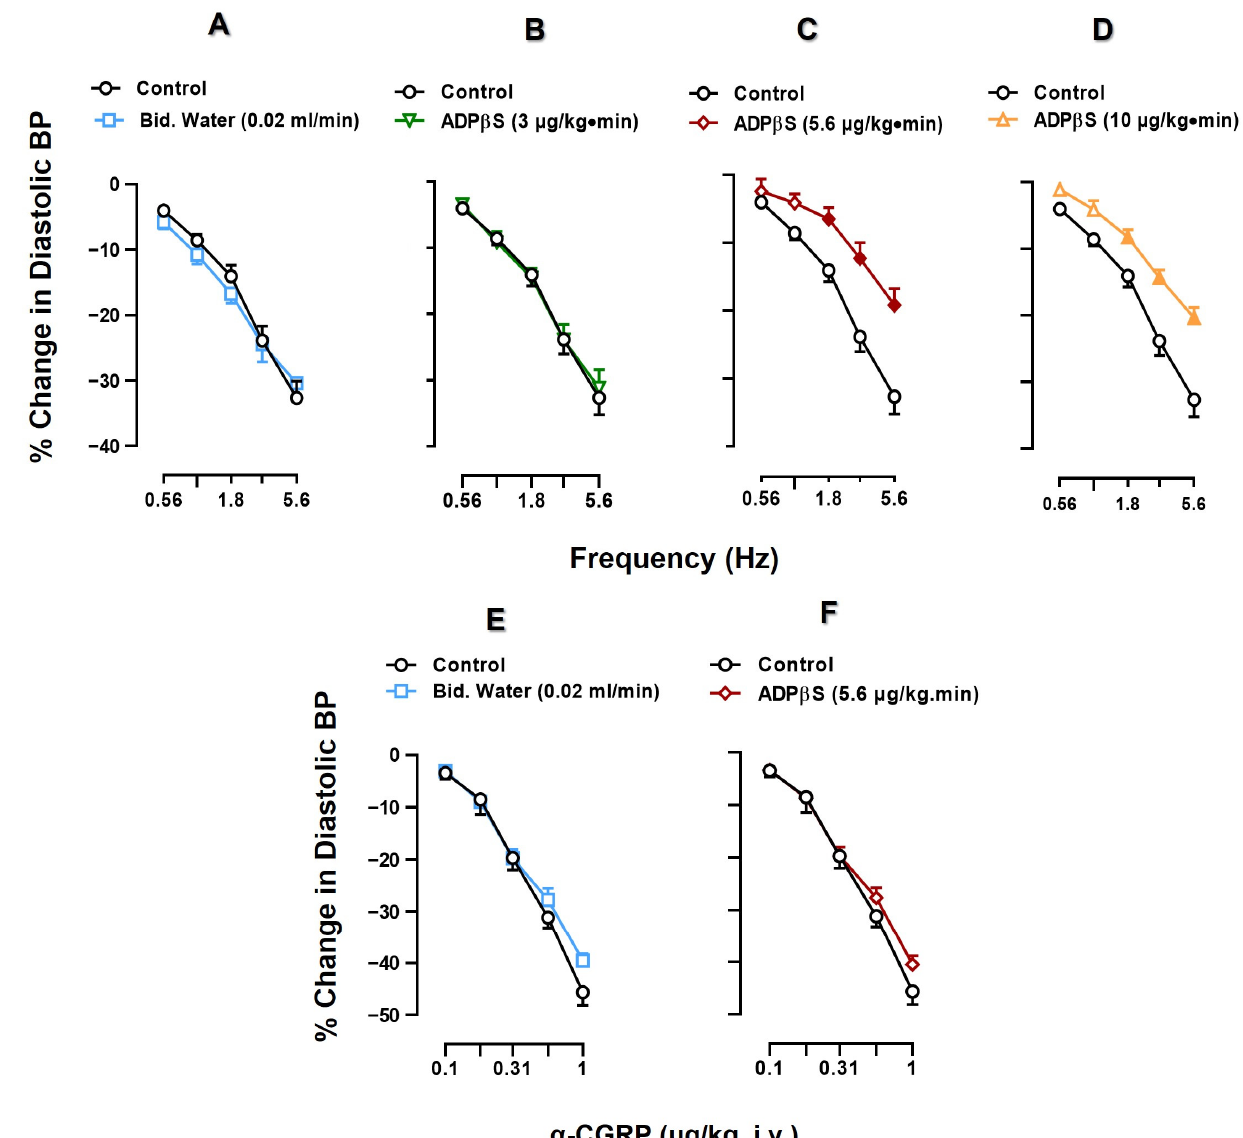
Figure 1. Comparative analysis of the effects produced by infusions of bidistilled water (Bid. Water) or ADP β S on the vasodepressor responses produced by electrical stimulation or exogenous α -CGRP. Effect of i.v. continuous infusions (after 10 min) of ( A ) bidistilled water (0.02 mL/min; ), ( B ) ADP β S (3 µ g/kg · min; (cid:53) ), ( C ) ADP β S (5.6 µ g/kg · min; ) and ( D ) ADP β S (10 µ g/kg · min; (cid:52) ) on the vasodepressor CGRPergic responses (peak changes) induced by spinal electrical stimulation; and effect of i.v. continuous infusions (after 10 min) of ( E ) bidistilled water (0.02 mL/min; ) and ( F ) ADP β S (5.6 µ g/kg · min; ) on the vasodepressor responses (peak changes) induced by i.v. bolus (cid:51) of exogenous α -calcitonin gene-related peptide ( α -CGRP). Data are shown as percentage (%) change in diastolic blood pressure. Solid symbols indicate a significant difference ( p < 0.05) against the corresponding control response ( ). Values are indicated as means ± SEM (n = 6 for each (cid:35)